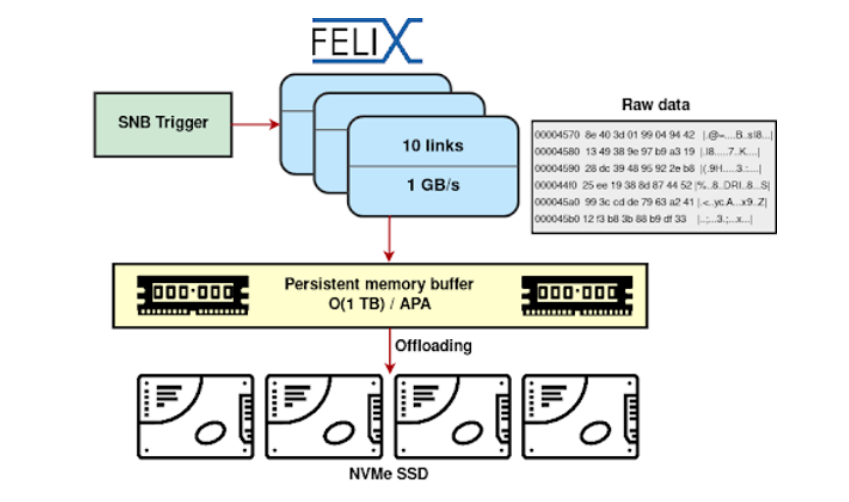
Figure 6. One possible solution for storing the supernova burst events, based on persistent memory modules on the FELIX hosting